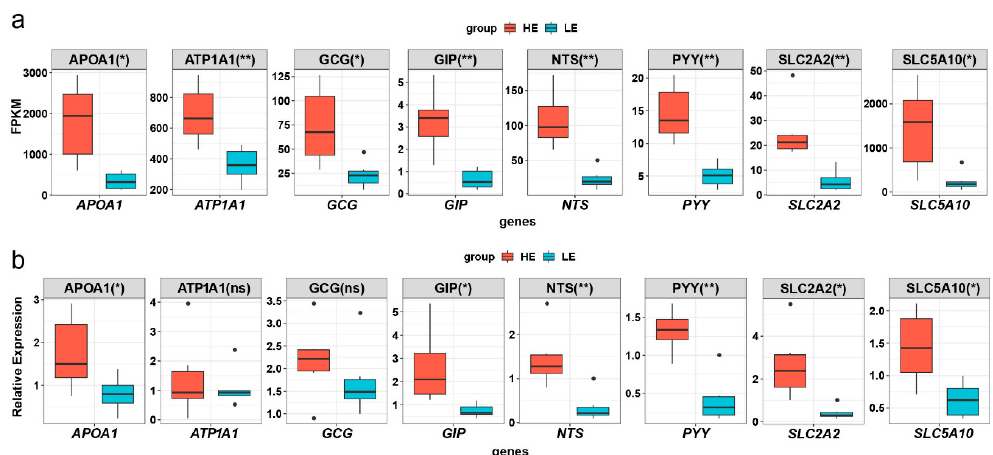
Figure 6. Quantitative real time polymerase chain reaction (qPCR) validation of eight DE genes. ( a ) Boxplot of FPKM expression values for the eight DE genes in RNA-seq. The y-axis represents the FPKM expression level, and the x-axis represents the gene name. The color of boxplot represents either the extremely high feed efficiency (HE)-group (red) or extremely low feed efficiency (LE)-group (blue). ( b ) Boxplot of the APOA1 , ATP1A1 , GCG , GIP , NTS , PYY , SLC2A2 , and SLC5A10 relative expression levels normalized to ACTB . * represents p- value < 0.05 in the HE-group compared with the LE-group. ** represents p- value < 0.01 in the HE-group compared with the LE-group.